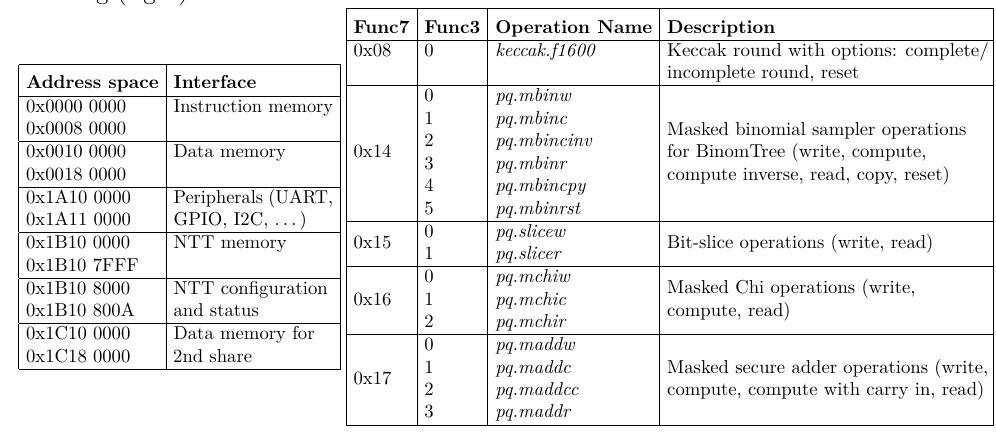
Table 9: Memory map RISC-V platform (left) and instruction set extensions with R-type encoding